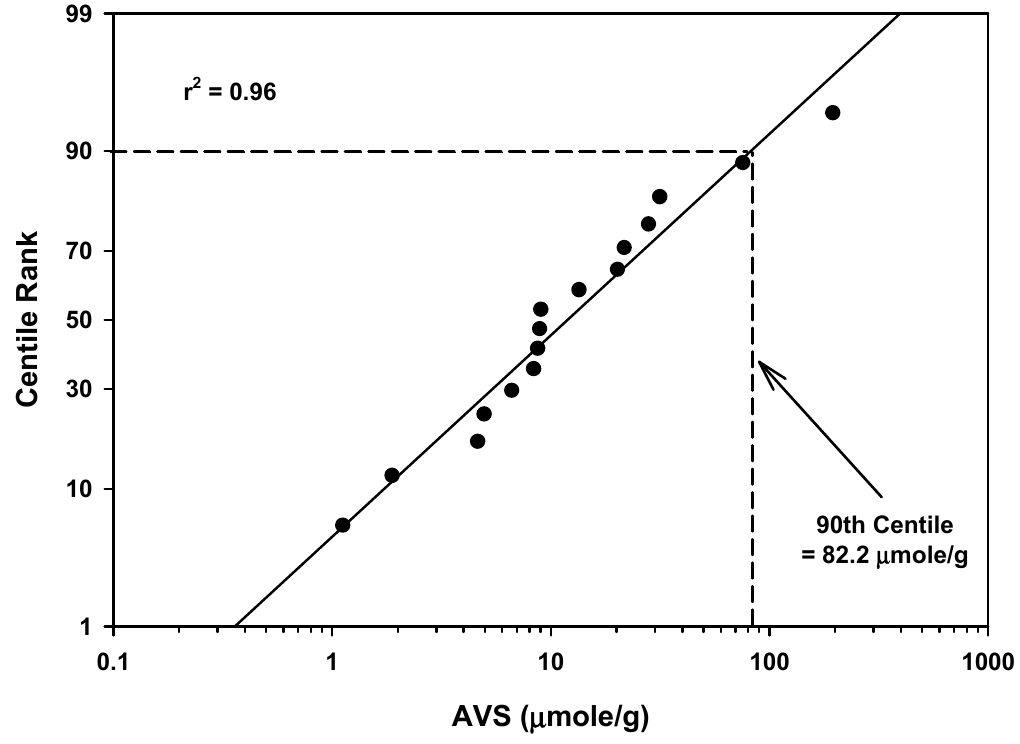
Figure 6. Regression of AVS field study means data for rivers against a probability scale showing the 90th centile rank.